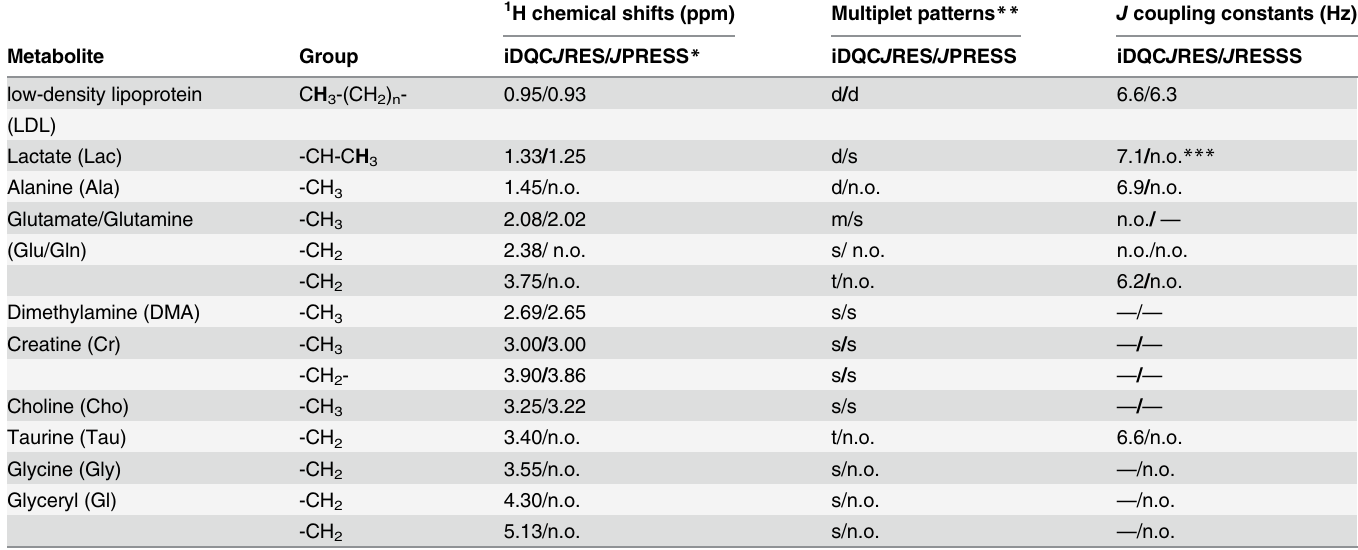
Table 2. Comparison of 1H NMR spectral results of a whole fish ( Harpadon nehereus ) obtained using iDQC J RES and conventional J PRESS methods. 1 H chemical shifts